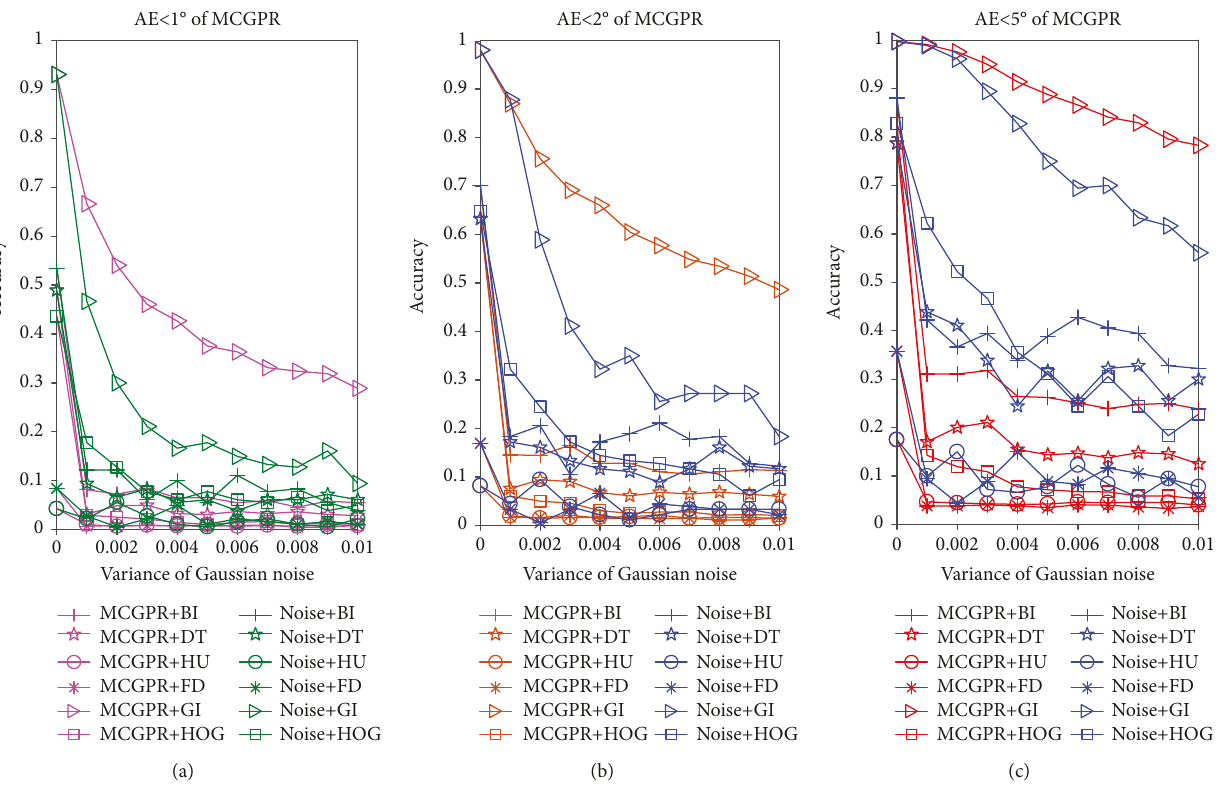
Figure 7: Noise robustness results of MCGPR for pose estimation (% AE less than a